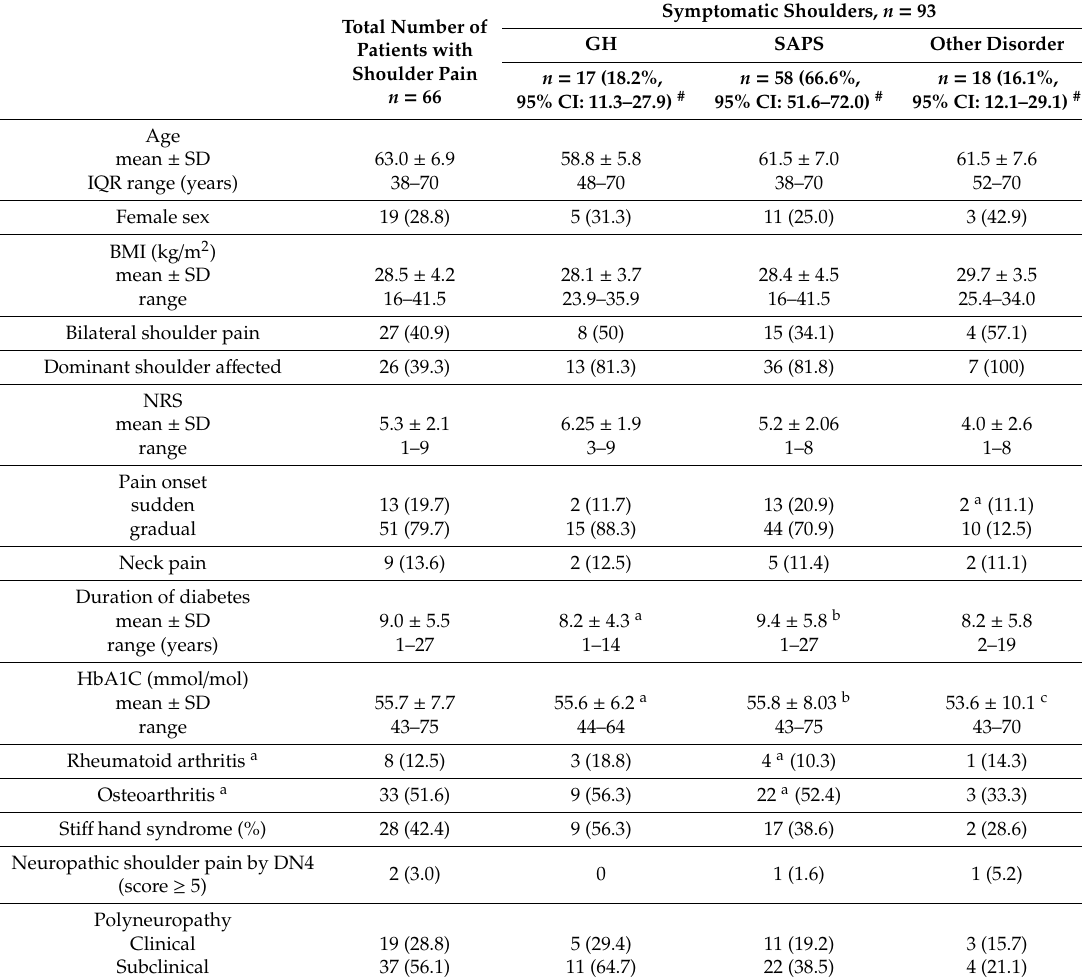
Table 1. Physical-examination-diagnosed shoulder disorders with the comparison of the demographic